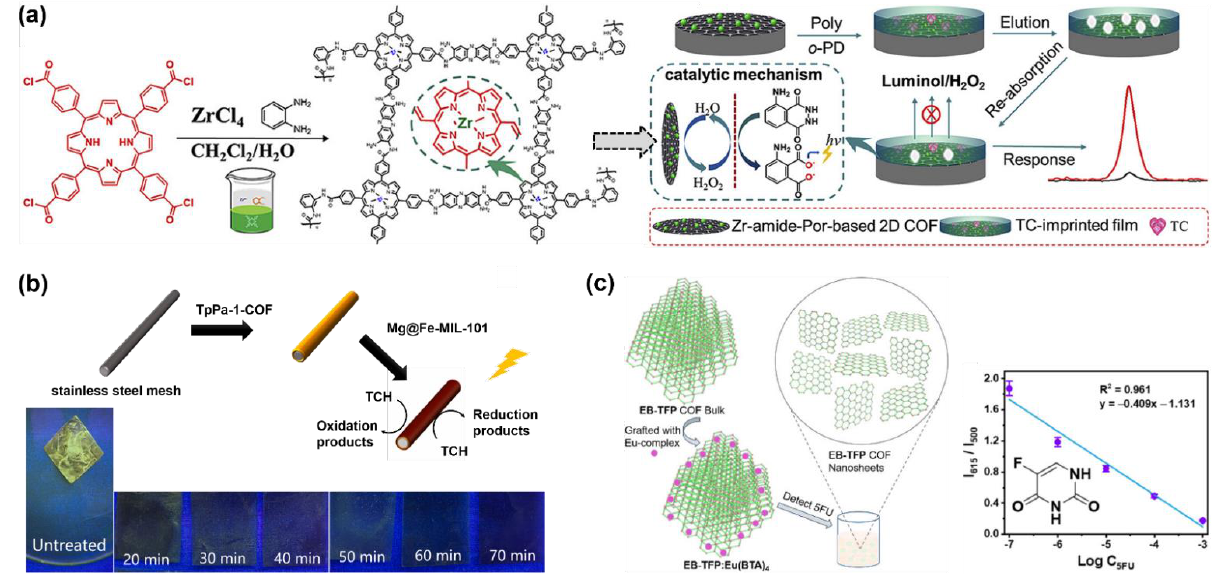
Figure 11. ( a ) Zr-coordinated amide porphyrin-based COF for tetracycline detection with the aid of molecular imprinting technology [144]. Copyright 2019 Elsevier B.V.; ( b ) The preparation of Mg@Fe − MIL − 101/TpPa − 1 − COF, and its fluorescent detection of tetracycline realized simul- taneously with photocatalytic tetracycline removal [152]. Copyright 2021 Elsevier B.V.; ( c ) EB- TFP:Eu(BTA) 4 for the detection of 5-Fluorouracil [154]. Copyright 2021 American Chemical